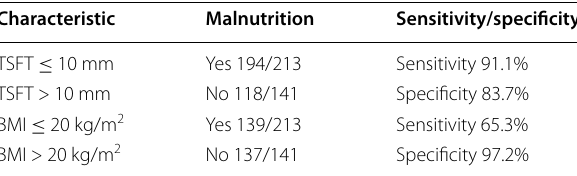
Table 5 Sensitivity and specificity of triceps skinfold thickness (TSFT) and body mass index (BMI) in detecting